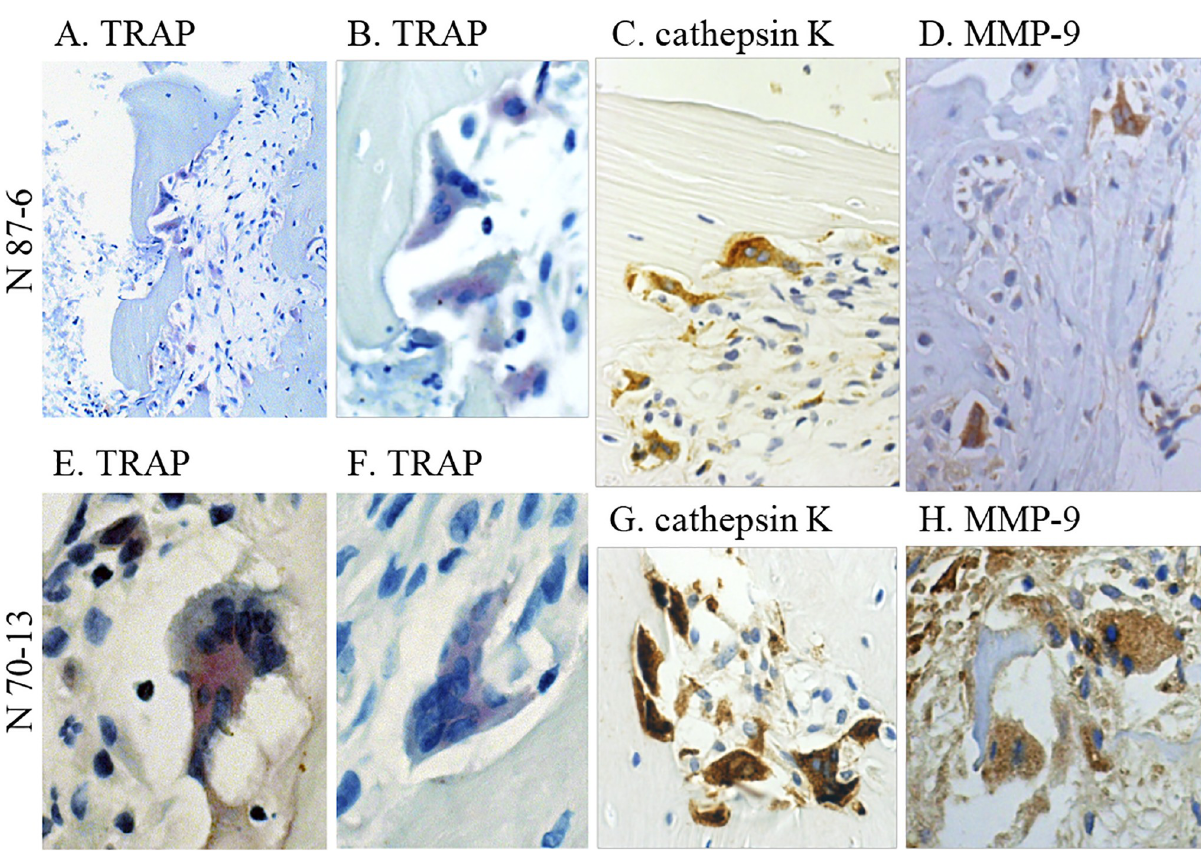
Fig 3. Histochemistry of the knee joint section of EBV-infected hu-NOG mice. (A–D) Joint sections from an EBV-infected mouse (N 87–6). (A and B) Joint sections stained for TRAP. TRAP observed in multinucleated cells at the bone erosion site stained red violet. (C) Joint section immunostained for human cathepsin K. Multinucleated cells positive for human cathepsin K stained brown with the anti-human cathepsin K antibody. (D) Joint section immunostained for human MMP-9. Multinucleated cells positive for MMP-9 stained brown with the anti-human MMP-9 antibody (dilution, 1:25). (E–H) Joint sections from another EBV-infected mouse (N 70–13). (E and F) Joint sections stained for TRAP. TRAP-positive multinucleated cells were found in the knee joint tissue. Joint sections immunostained for human cathepsin K (G) and human MMP-9 (dilution, 1:50) (H). These multinucleated cells stained positively with the anti-human cathepsin K antibody and the anti-human MMP-9 antibody. Original magnification, A: 200 × , others: 400 × . Republished from [Nagasawa Y, Ikumi N, Nozaki T, Inomata H, Imadome K, et al. Human osteoclasts are mobilized in erosive arthritis of Epstein-Barr virus-infected humanized NOD/Shi-scid/IL2R γ null mice. 2014 ACR/ARHP Annual Meeting. Abstract number:2340.] under a CC BY license, with permission from [American College of Rheumatology], original copyright [2014].